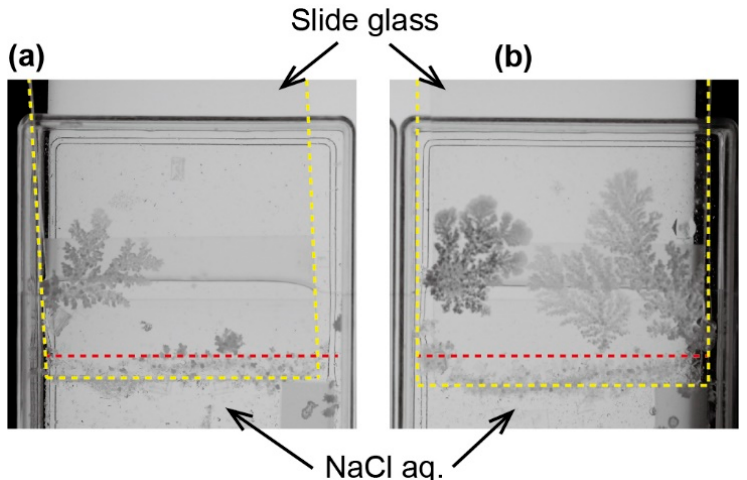
Figure 2. Dendritic crystal growth of NaCl on a large-sized slide glass. Contact angle of water droplet on the glass plate was ( a ) 65° and ( b ) 50°. Red and yellow broken lines indicate three-phase contact line and contour of slide glass, respectively.